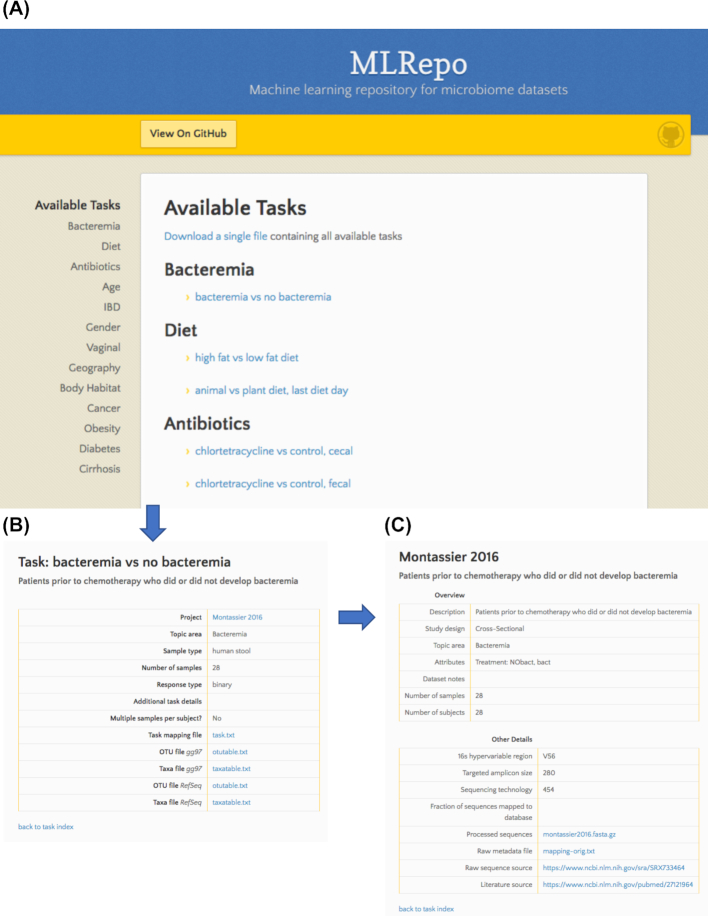
Screenshots of ML Repo web interface. (A) Available classification and regression tasks are listed by high-level phenotype categories for browsing. (B) Individual task webpages contain links to files for classifying a specific task, as well as relevant task-specific metadata. (C) Individual dataset webpages contain relevant metadata pertaining to the entire dataset, as well as links to raw metadata files and sequencing data.